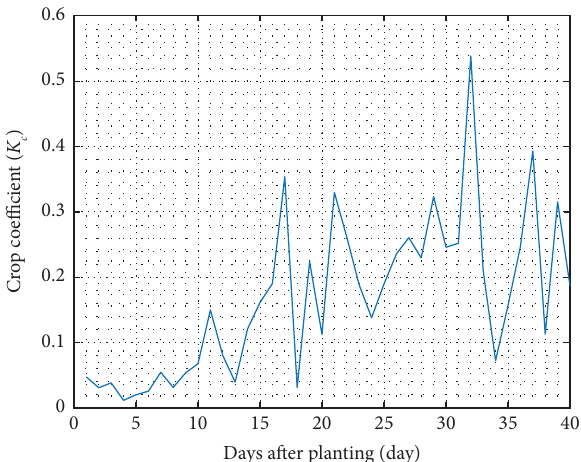
Figure 8: Crop coefcient during mustard pagoda